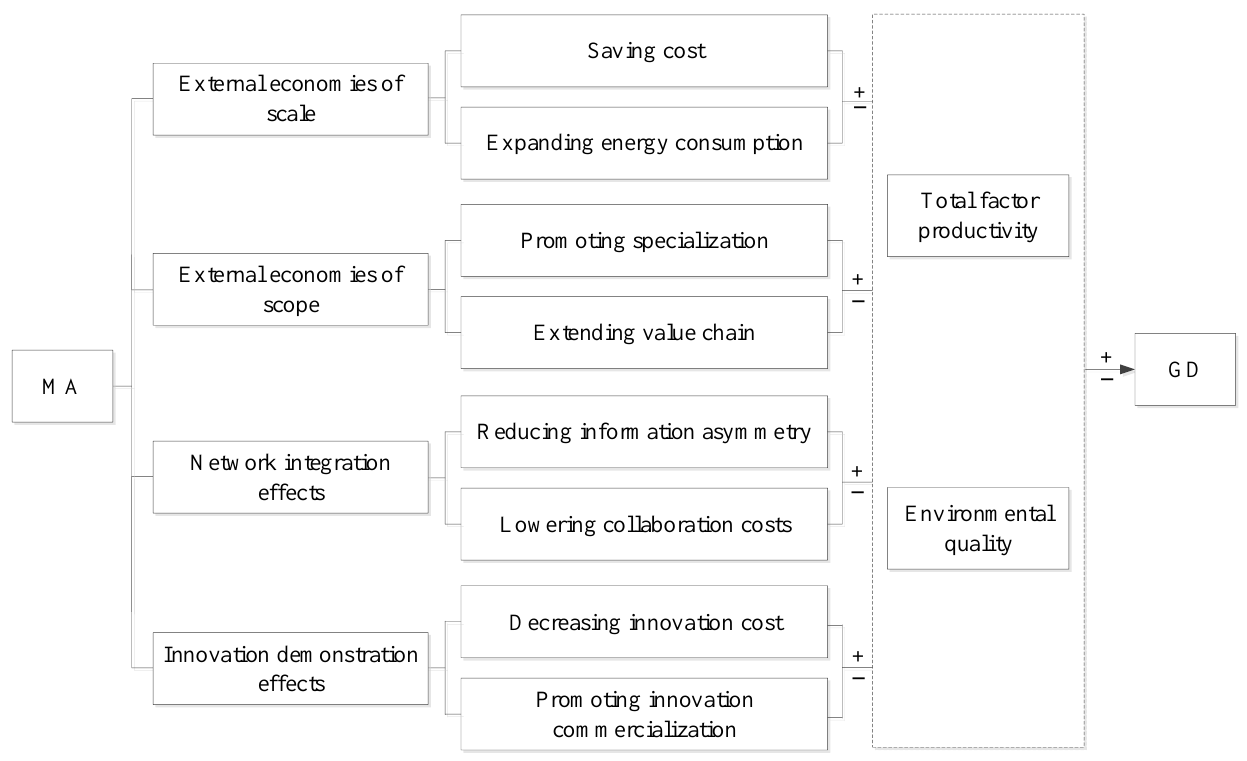
Figure 1. Direct path for MA to influence GD.